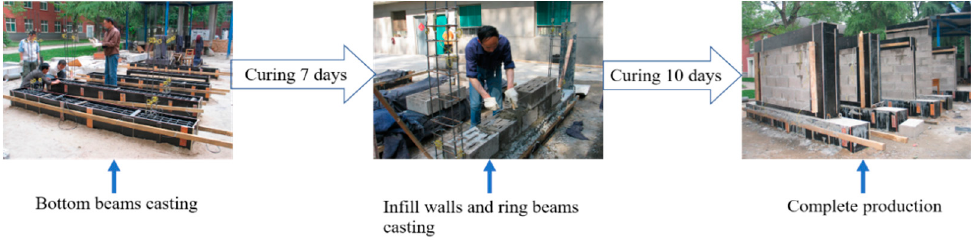
Figure 4. Process of the construction of masonry wall specimens.